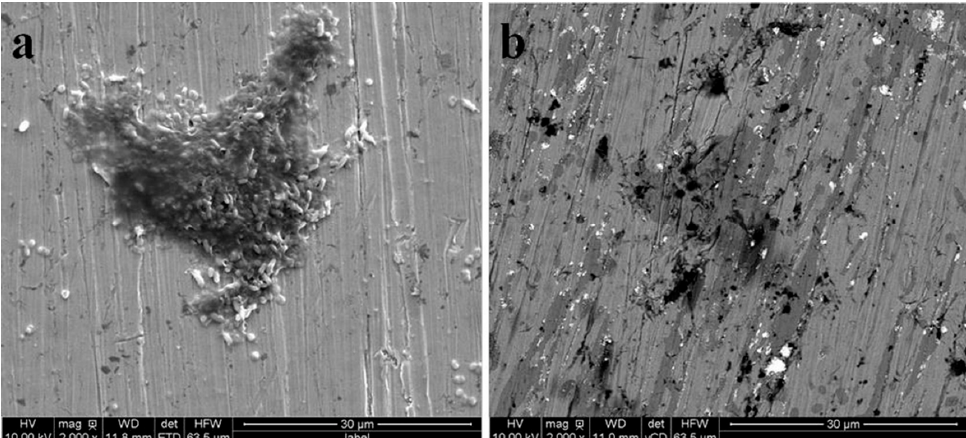
Figure 6. SEM images of the steel surfaces ( a ) before and ( b ) after removing the biofilm and corrosion by-products. These surfaces were initially exposed to artificial seawater containing Bacillus sp. for 90 days. Afterwards, the biofilm and corrosion by-products were removed from the surface.